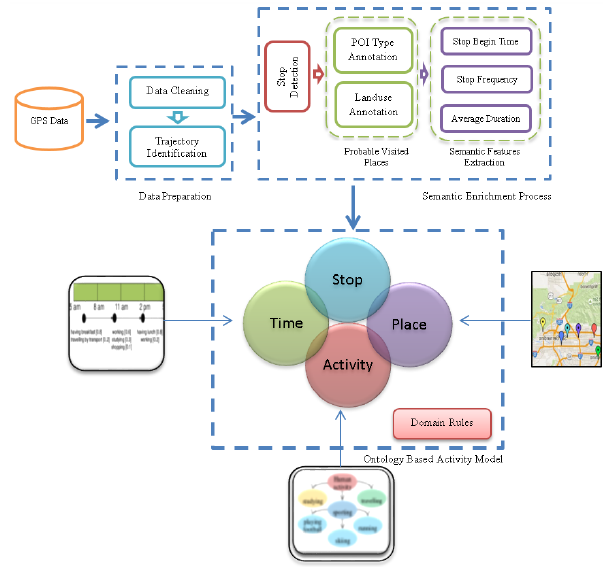
Figure 4. Activity recognition